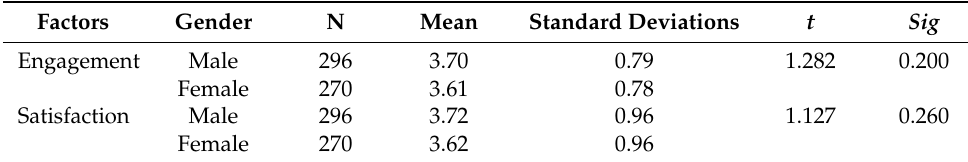
Table 2. Independent t -test results to test gender-based differences.